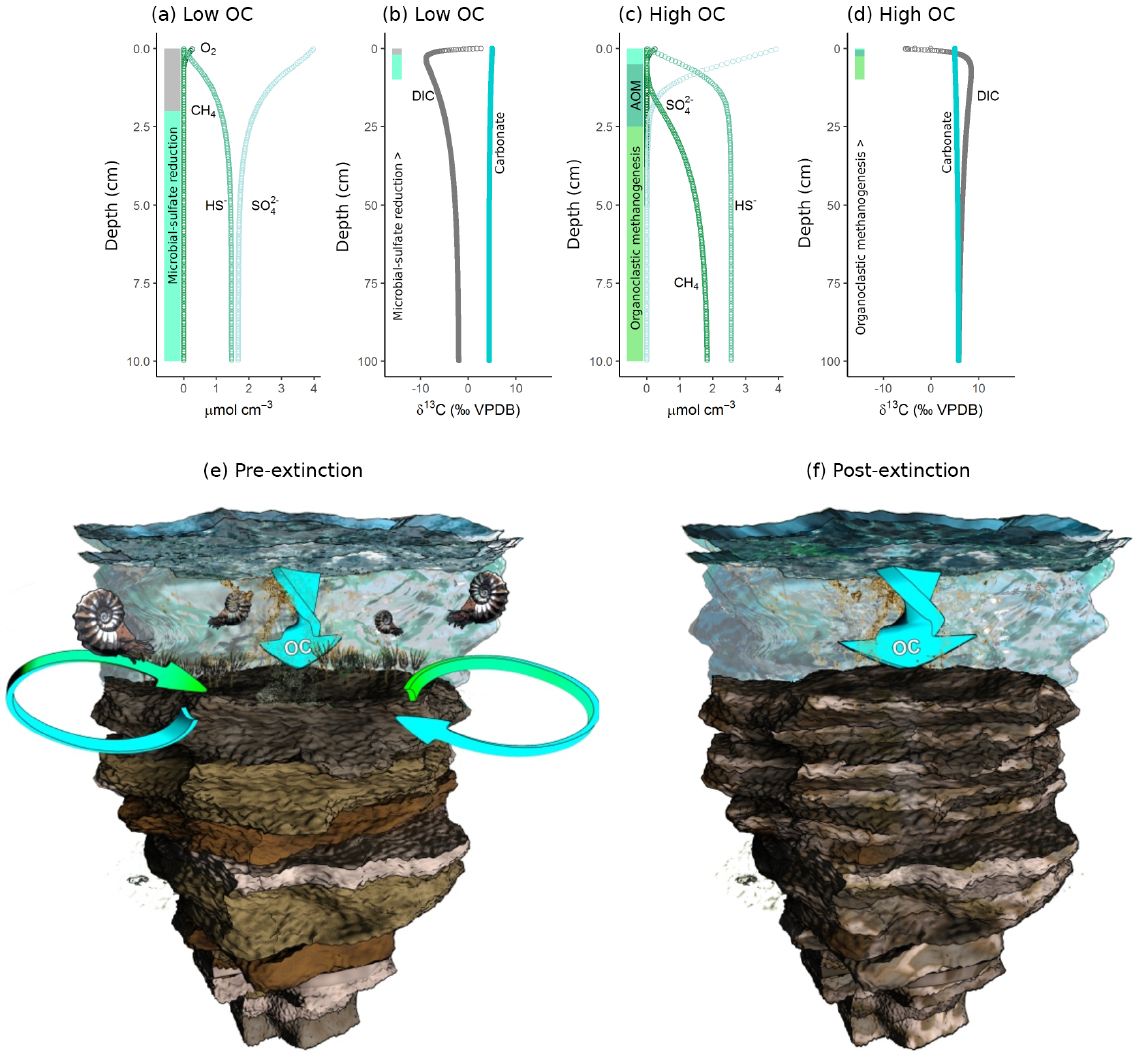
Figure 4. Diagenetic depth profiles of Late Permian sea-floor sediments of (a) oxidized and reduced solutes under a low shelf OC flux 500µmolcm − 3 yr − 1 , (b) DIC and carbonate δ 13 C forced with a low shelf OC flux 500µmolcm − 3 yr − 1 , (c) oxidized and reduced